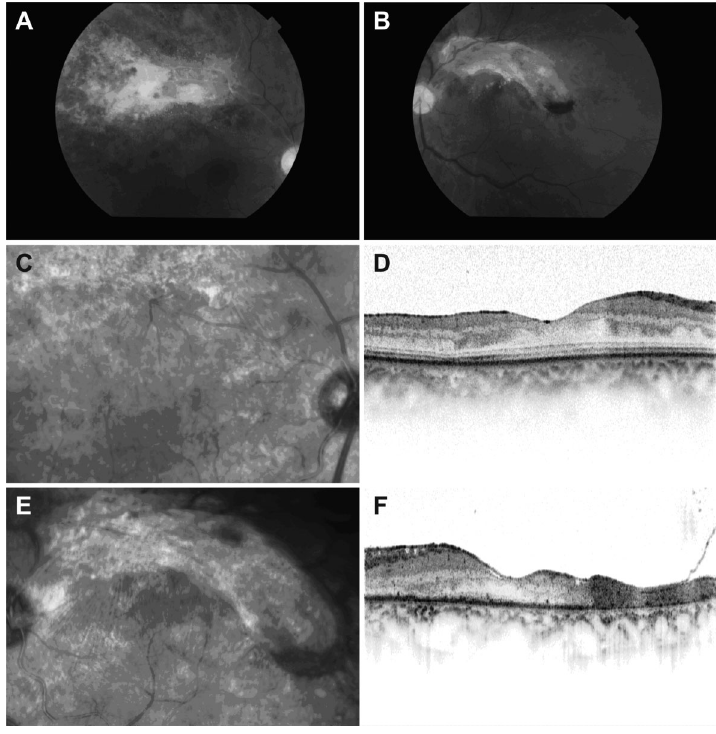
Figure 1. Bilateral cytomegalovirus retinitis of the patient with AIDS. A , Retinitis in the process of cicatrization with hemorrhage in the superior temporal arcade of the right eye. B , Cicatrization of human cytomegalovirus retinitis of the left eye involving the superior temporal arcade and parts of the posterior pole and the macula. C , Detailed image of retinitis of the right eye. D , Tomography of the macular region of the right eye demonstrating its preserved thickness. E , Detailed image of retinitis of the left eye. F , Thinning and disorganiza- tion of the macular zone layers of the left eye,